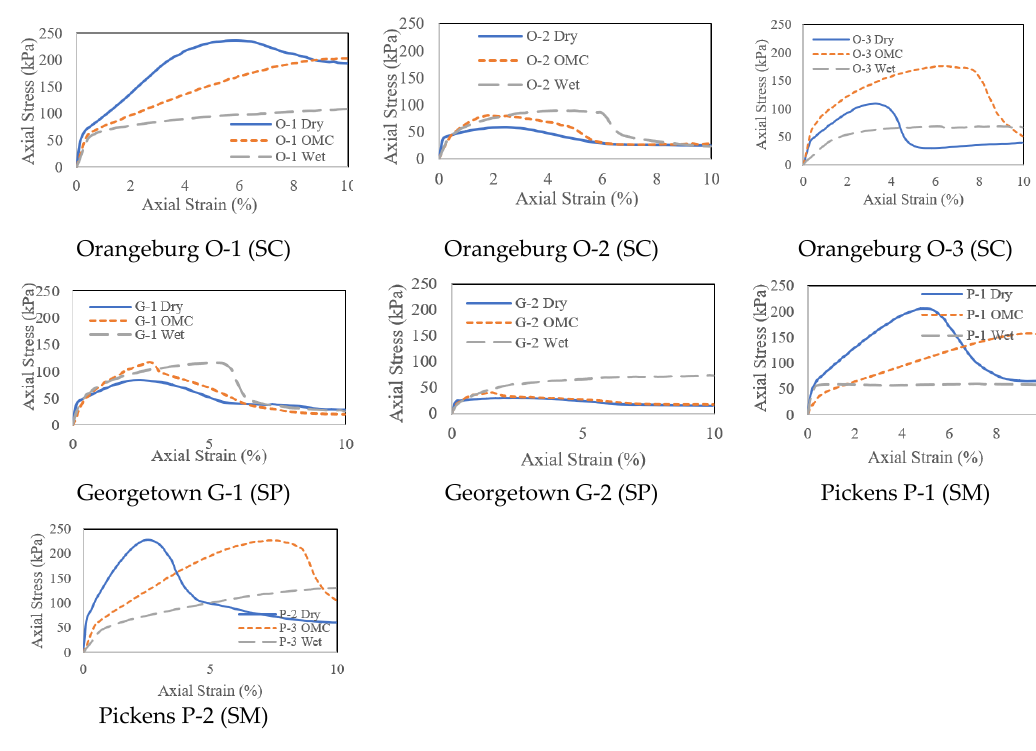
Figure 4. QS Test Results.